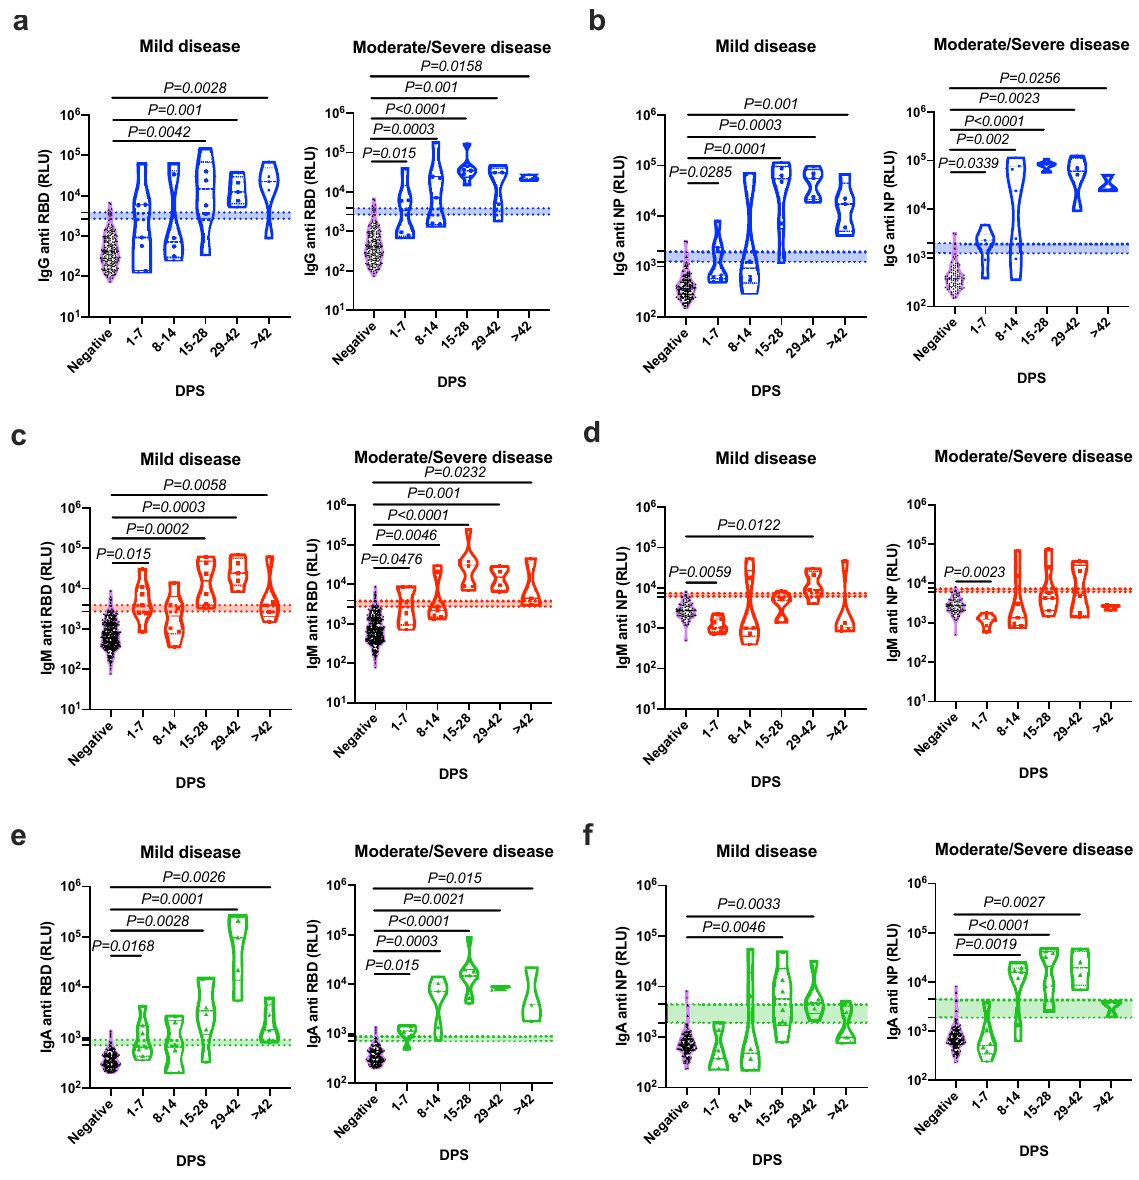
Figure 3. Correlation of the antibodies’ response to the disease severity. Peripheral blood was collected from hospitalized COVID-19 patients. Negative samples were obtained from true SARS-CoV-2 negative patients (i.e., prior to the SARS-CoV-2 pandemic). Plasma was obtained, diluted 1:50, and added to a 96-well plate precoated with SARS-CoV-2 RBD ( a , c , e ) or NP ( b , d , f ) antigens. Patients’ antibody results were grouped according to their disease severity and graphed against DPS. Data were calculated using GraphPad Prism 8; the dotted line represents the calculated cutoff values (95% and 98% sensitivity) discriminating between positive and negative samples. Statistical analysis was performed using a Nonparametric Kruskal–Wells test for multiple comparisons against negative samples. Significant P values are